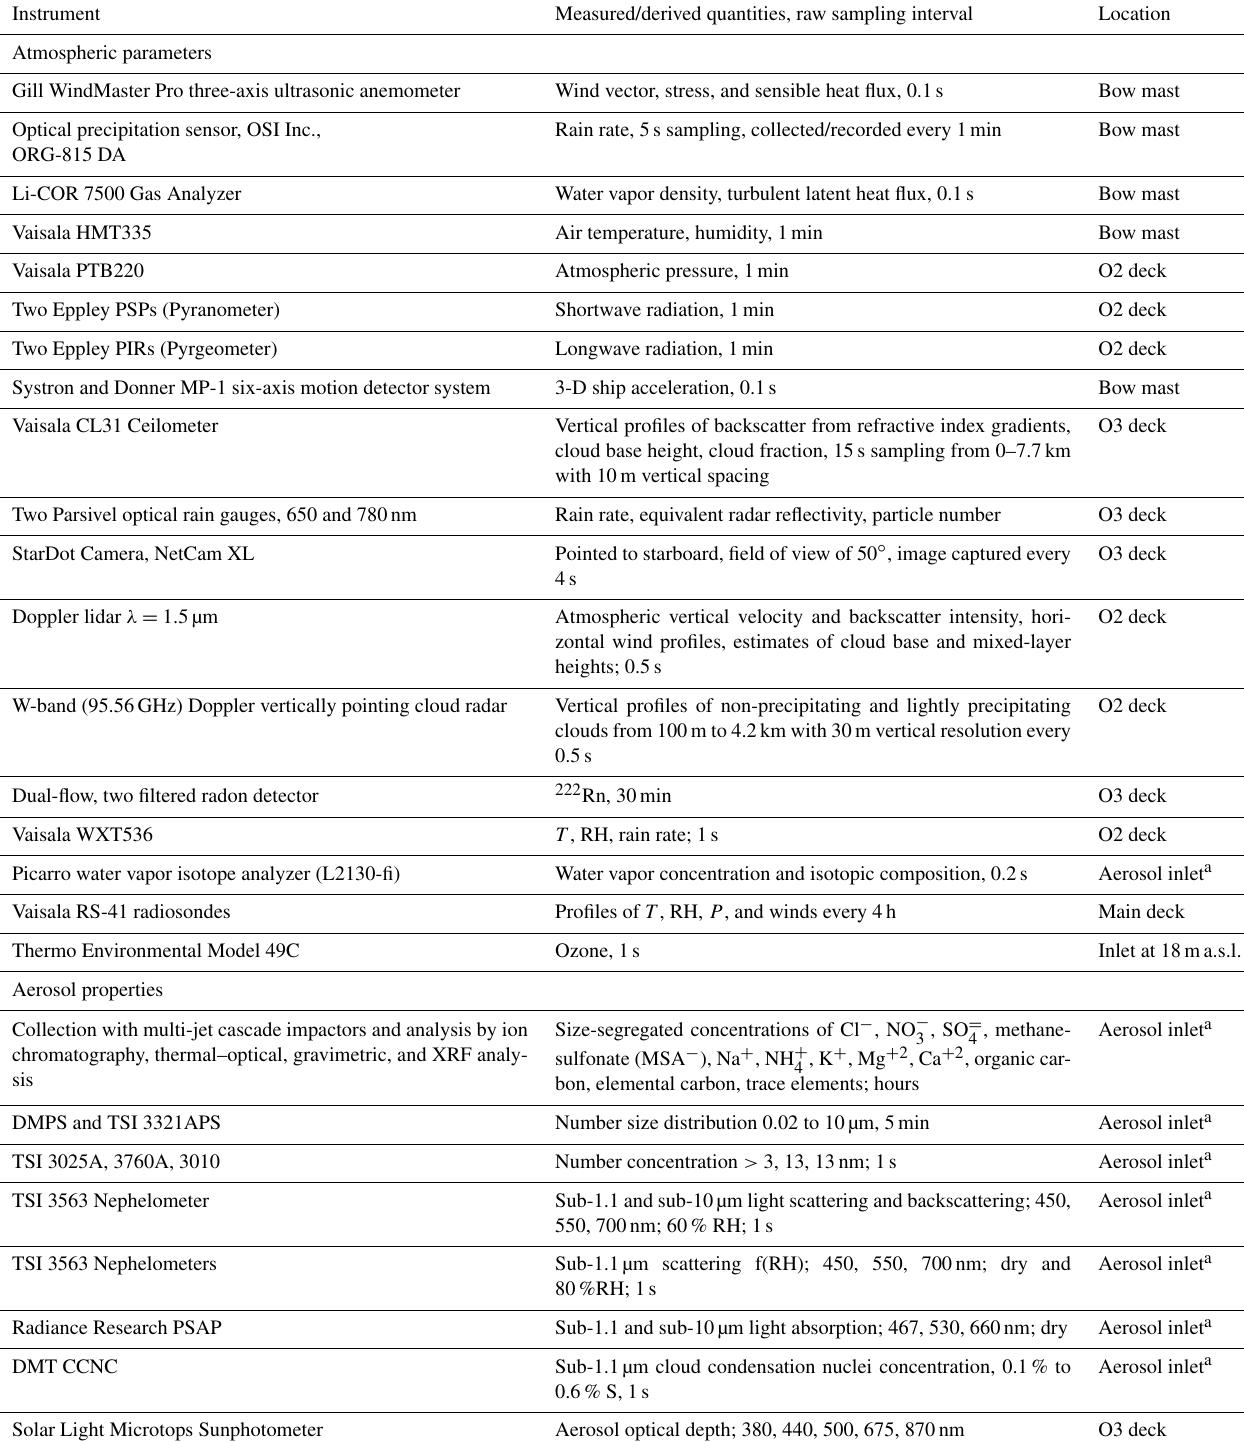
Table 5. Instrumentation on board the RV Ronald H. Brown for the measurement of atmospheric and aerosol parameters. The O2 and O3 decks were two and three levels above the main deck,